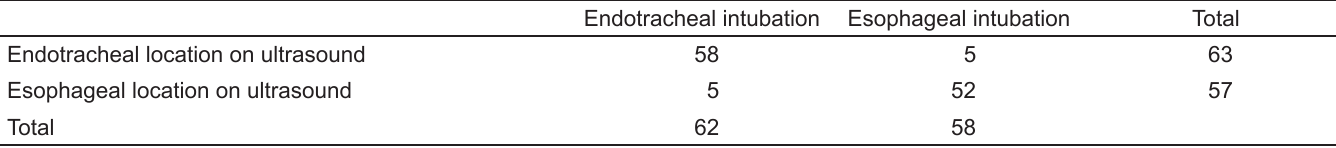
Table 2. Accuracy of the dynamic technique for endotracheal